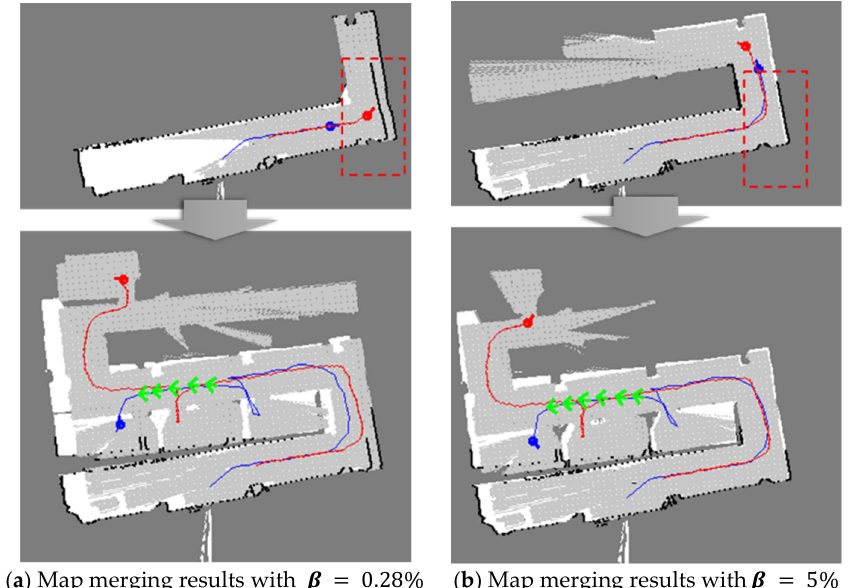
Figure 8. Qualitative comparison of the merged maps according to β .